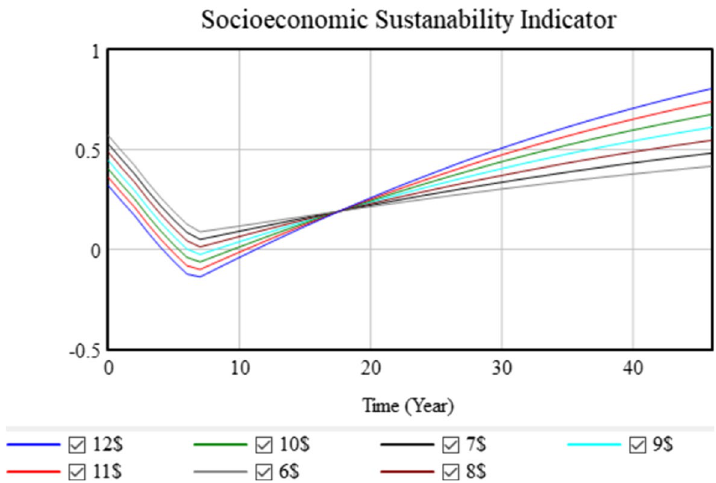
Fig. 13 The Socioeconomic Sustainability Indicator dynamic behavior for the concession price